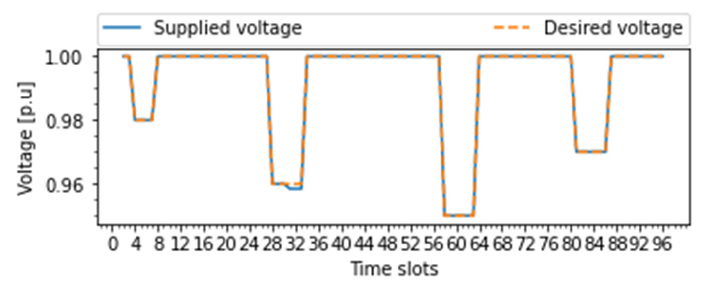
Figure 5. Voltage deviations with DQN-based MPC Figure 5 . Voltage deviations with DQN ‐ based MPC approach.